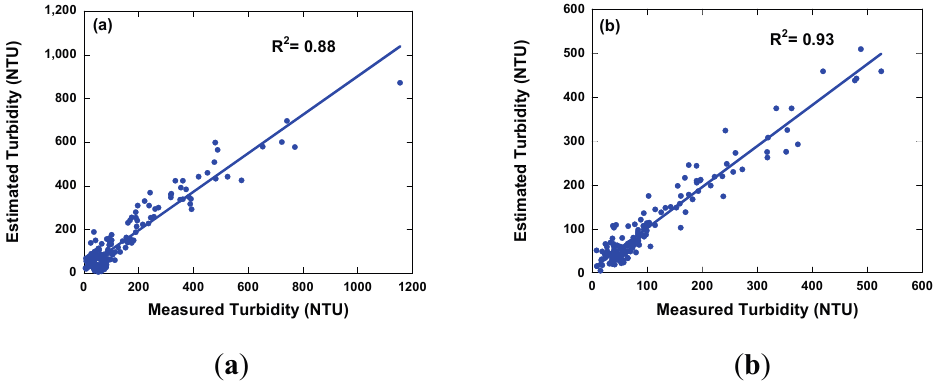
Figure 5. The correction between measured turbidity from in situ sampling and estimated turbidity derived from field spectral using multiple regression equation. ( a ) all data; ( b ) exclude above 600